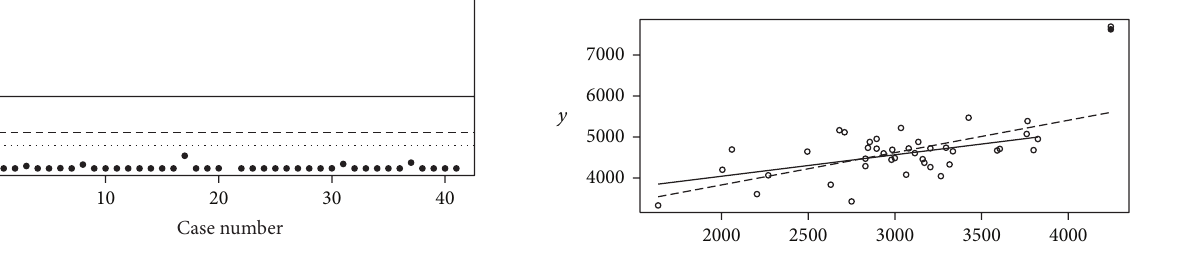
Figure 4: Corrected likelihood ratio test statistic for each case, with 95th ercentile of the empirical distribution under 𝐻 0 shown for the first 𝑘 order statistics for corrected likelihood ratio test: 𝑘 = 1 (solid line), 𝑘 = 2 (dashed line), and 𝑘 = 3 (dotted line).